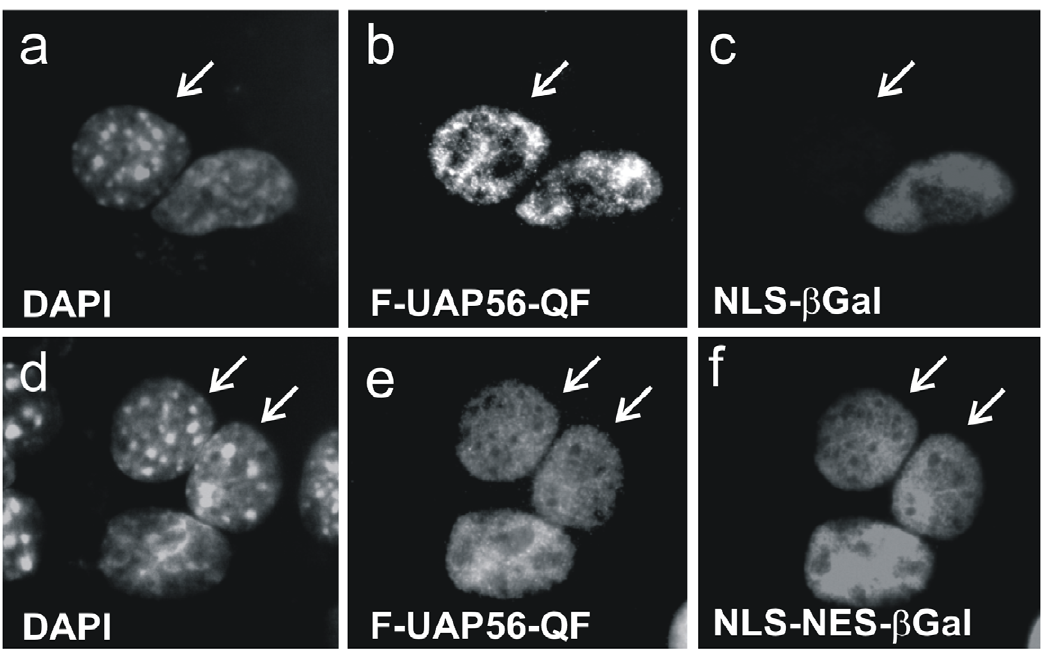
Figure 9. Nucleocytoplasmic shuttling of UAP56-Q289R + F312A . Heterokaryon analysis: HeLa cells were cotransfected with vectors encoding FLAG-UAP56-Q289R + F312A (F-UAP56-QF, panels a-f) and one of the internal control plasmids as indicated (a–c, + CFN- b Gal; d–f, + CFNrev- b Gal). Transfected cells were subjected to an interspecies heterokaryon assay as described before. Indirect immunofluorescence analysis was performed using polyclonal anti-FLAG serum (b and e) and monoclonal anti- b Gal-antibody (c and f). DAPI staining (a and d); murine nuclei are indicated by arrows.